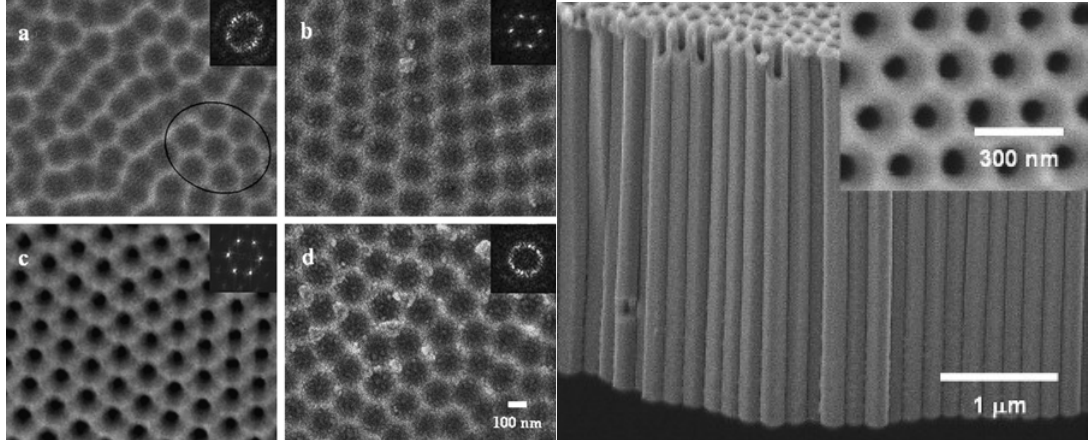
Figure 3. Scanning electron microscopes (SEM) of titanium substrate after removal of ( a ) first; ( b ) second; and ( d ) third nanotube array. Reprinted with permission from [30]. Copyright 2007 Elsevier.